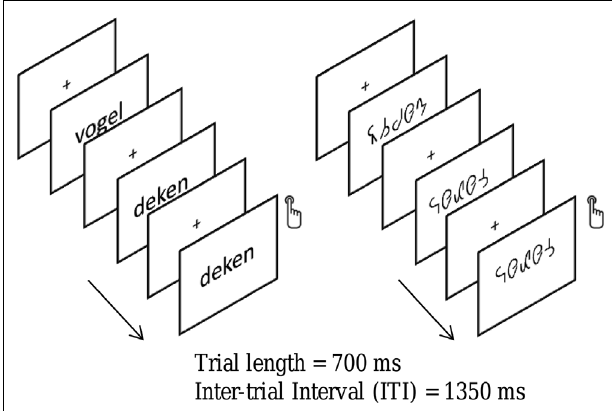
FIGURE 2 |An illustration of the word and symbol strings used in the present study. Children were required to attend to the strings and to depress a button whenever a string was identical to its immediate predecessor. Strings of words and letter-like symbols were presented in a blocked design. A fixation cross was presented in between